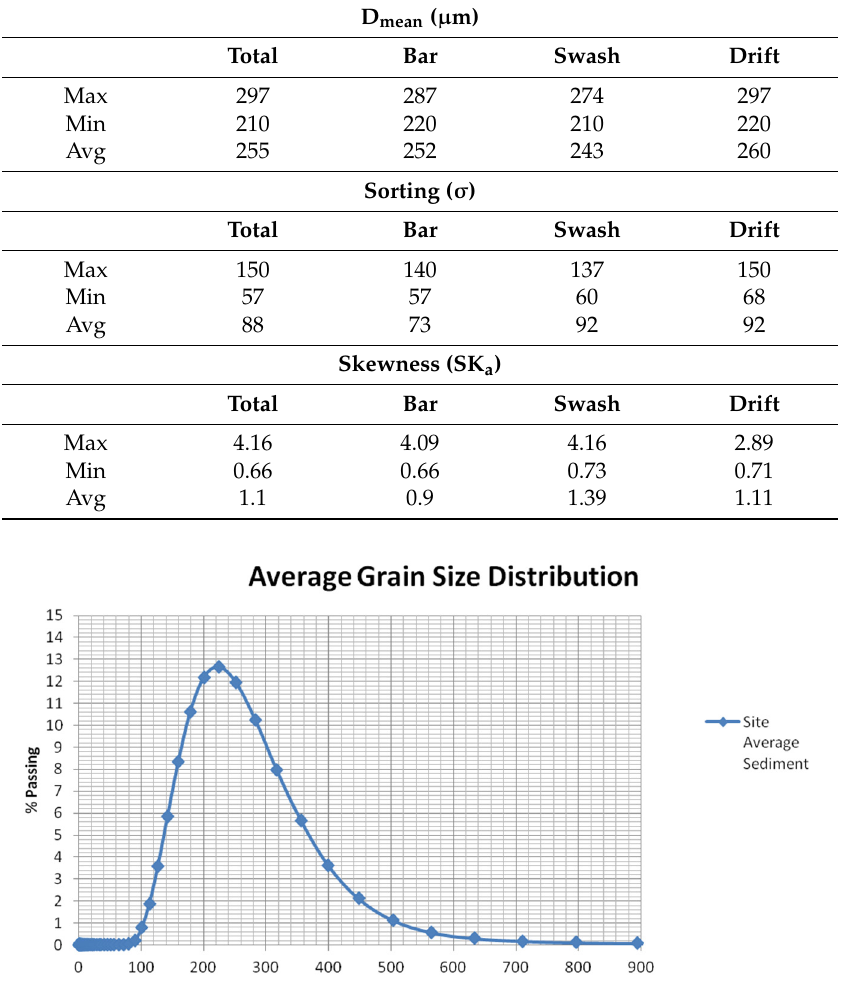
Figure 3. Average Grainsize Distribution of Site.